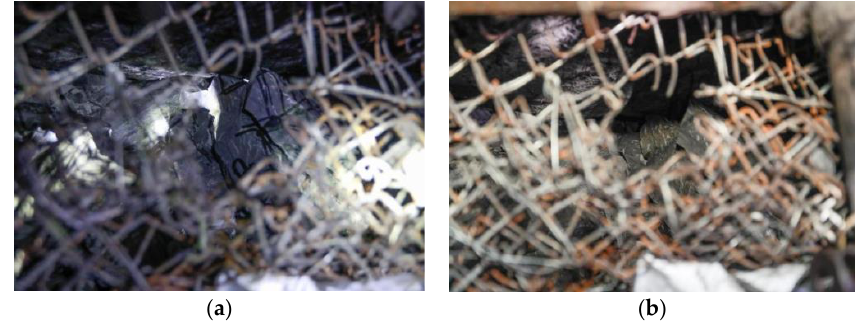
Figure 20. Falling form of roadside gangue. ( a ) Some gangue; ( b ) Some gangue.